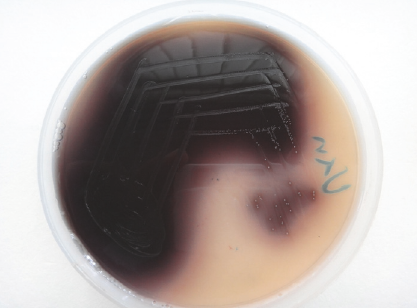
Figure 1: Bile Esculin Agar showing diffuse blackening of the medium by Enterococcus spp.